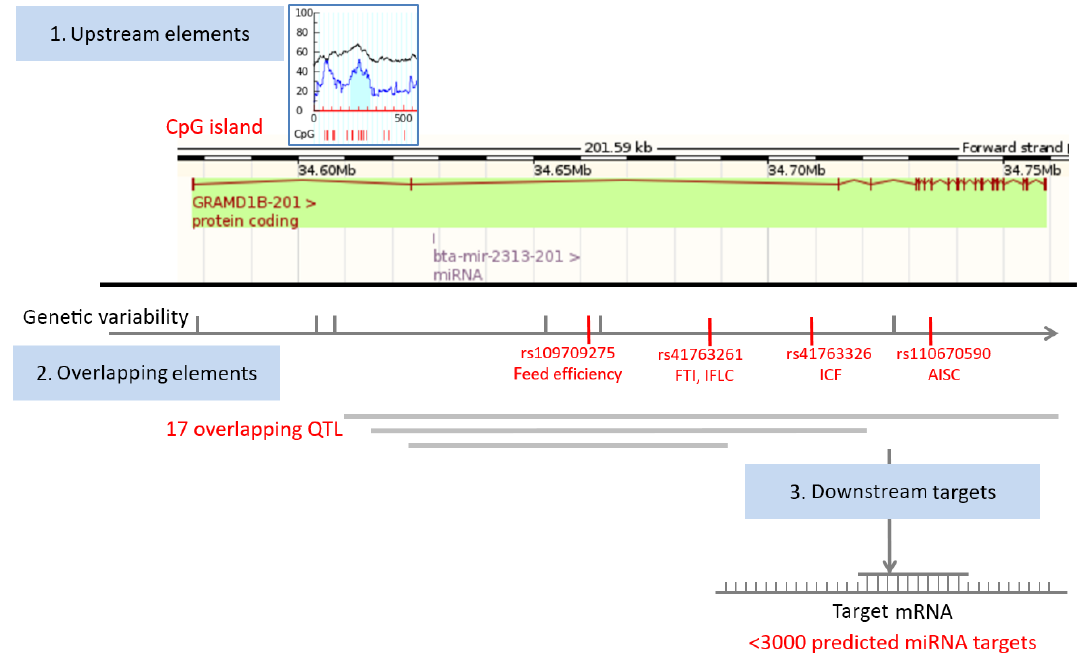
Figure 1. Map of miRNA bta-mir-2313 regulatory elements. The miRNA gene bta-mir-2313 is located within the intron 2 of the GRAMD1B gene at the same orientation relative to its host gene. Four functional polymorphisms are located downstream of the miRNA gene, three within intron 2 and one within intron 7 of the GRAMD1B gene. The miRNA gene has over 3000 predicted target genes. Legend: FTI – fertility index; IFLC – days from first to last insemination in cows; ICF – length in days of the interval from calving to first insemination; AISC – number of inseminations per conception in cows.